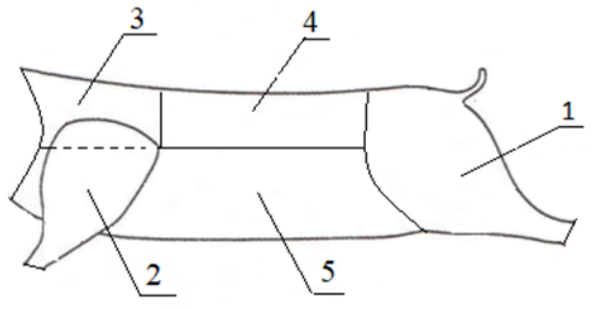
Figure 2. Primal cuts of the wild boar carcass: (1) ham, (2) shoul- der, (3) neck, (4) loin and (5) spare ribs with